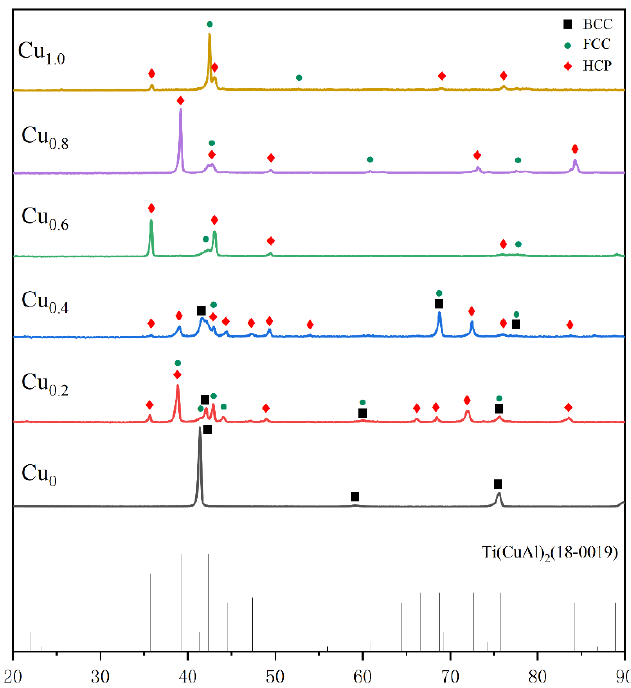
Figure 2. XRD patterns of AlCrTiV 0.5 Cu x lightweight HEAs.